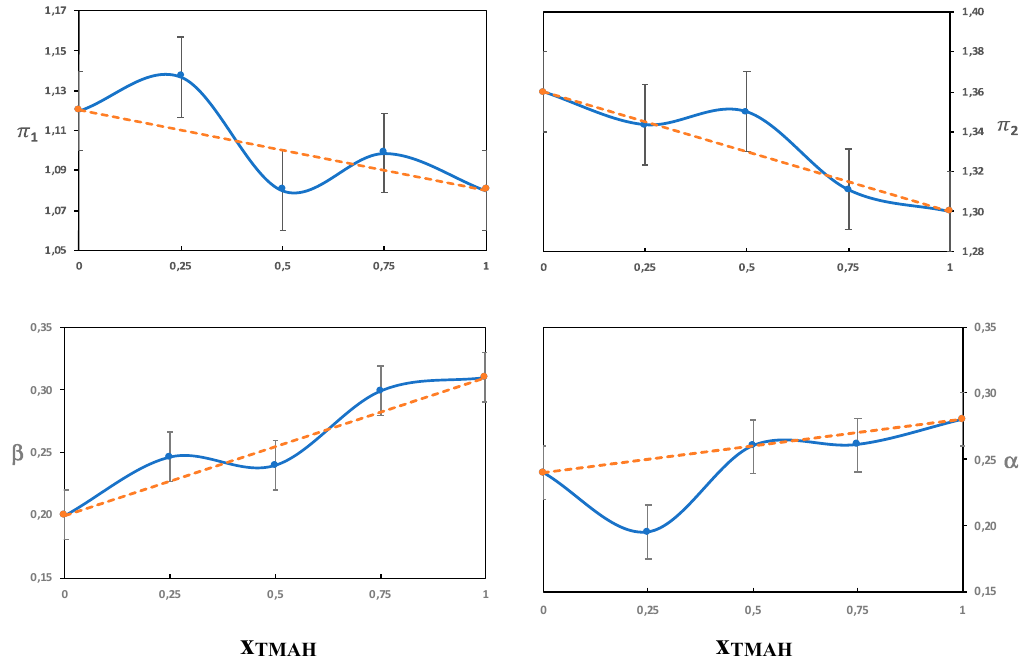
Figure 7. The Kamlet-Taft parameters as a function of the molar fraction of TMAH in solutions of 4 mol% NaOH/TMAH.